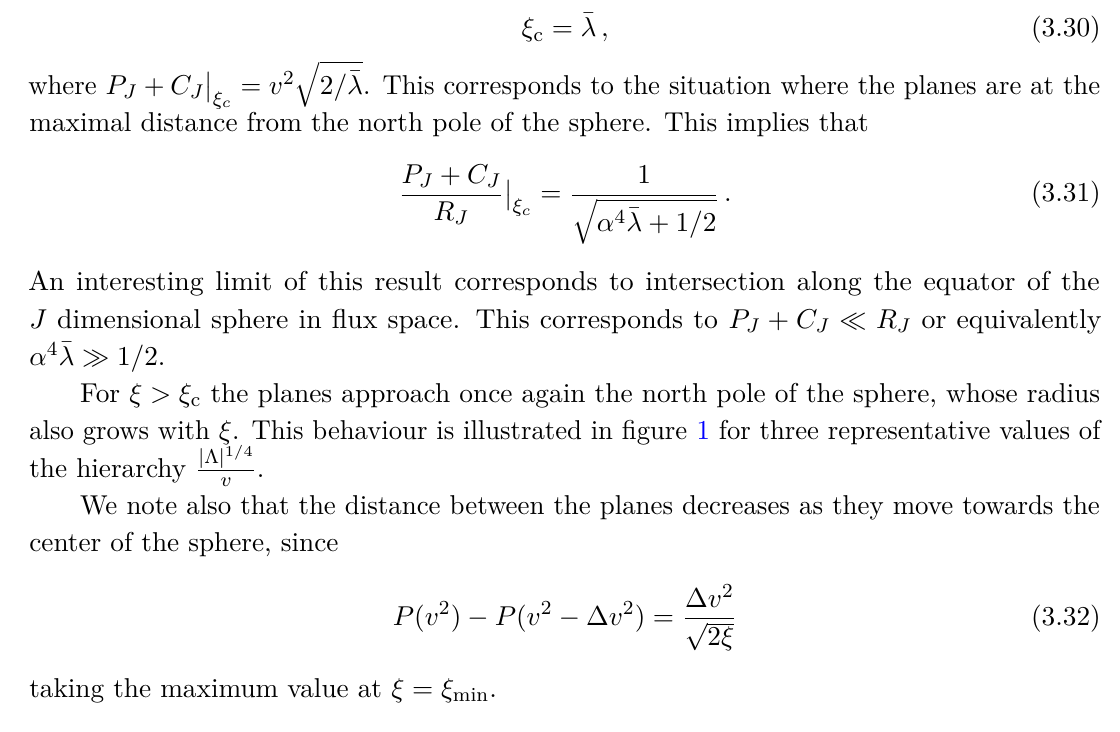
Figure 1 . Relative position between the planes and the spheres for different values of α ≡ | Λ | 1 / 4 Simultaneous solutions to the cosmological and hierarchy problems are possible for ξ ≥ ξ